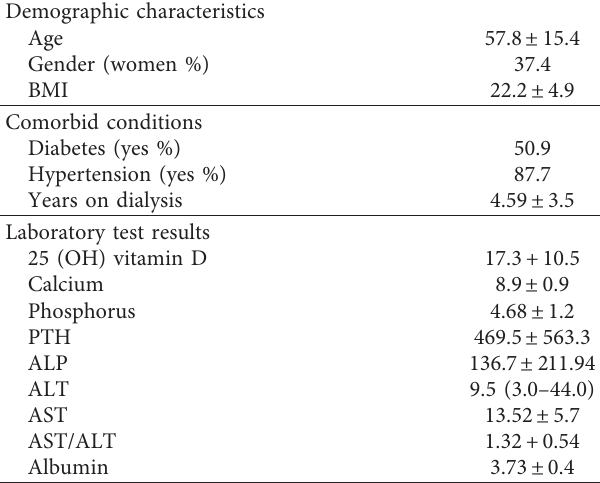
Table 1: Background, clinical, and lab characteristics of study participants ( n � 163).